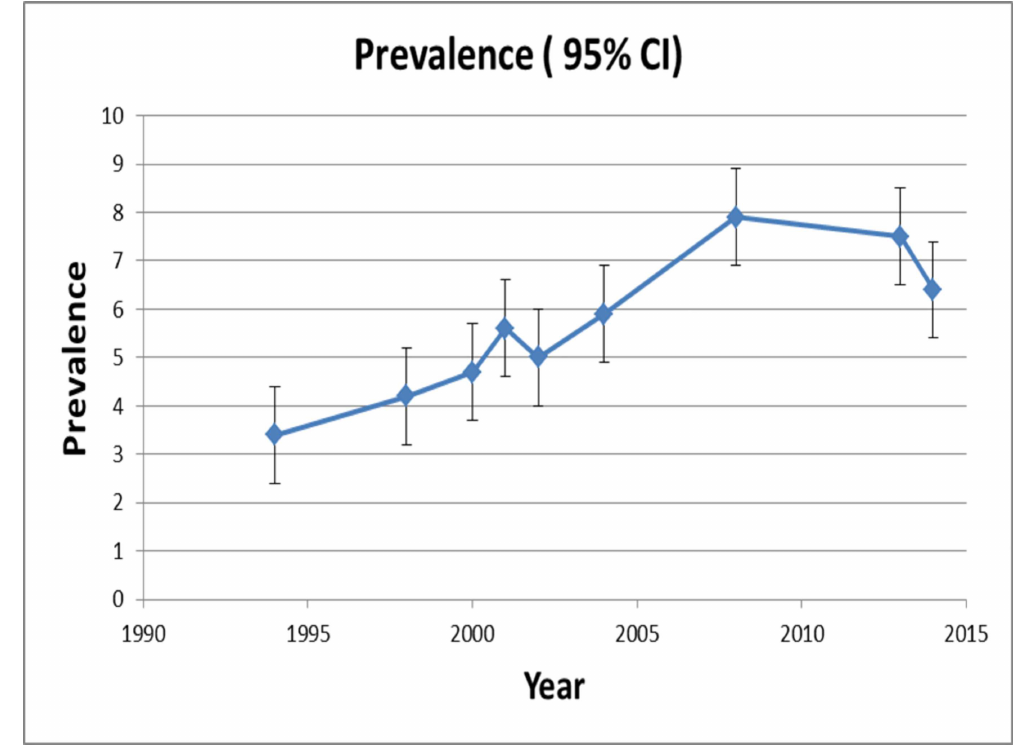
doubling of the prevalence of carers increasing from 3.7% 1994 to a peak of 7.9% in 2008 then declining to 6.7% by 2014. Table 2 highlights the unadjusted and adjusted odds ratios of carers over three specific years; 1994, 2004 and 2014 by a range of demographic variables. Multivariable analysis shows that in 2014 carers were more likely to be female (OR 1.43; 95% CI 1.00–2.05, p = 0.050), be aged 50–69 (OR 1.82; 95% CI 1.11–3.01 p = 0.0.019), be born in countries other than Australia, UK or Ireland, (OR 1.82; 95% CI 1.08–3.07, p = 0.02), be never married (OR 0.47; 95% CI 0.26–0.83, p = 0.011), declare their work status as ‘home duties’ (OR 1.88; 95% CI 1.02–3.48, p = 0.043) and have annual household incomes of $20,000–40,000 (OR 2.38; 95% CI 1.29–4.02, p = 0.005).